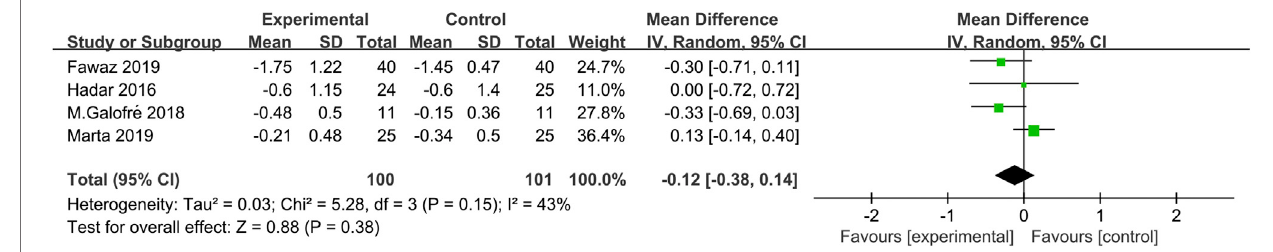
FIGURE 3 | Forest plot of PD reduction at implant level at 3 months.